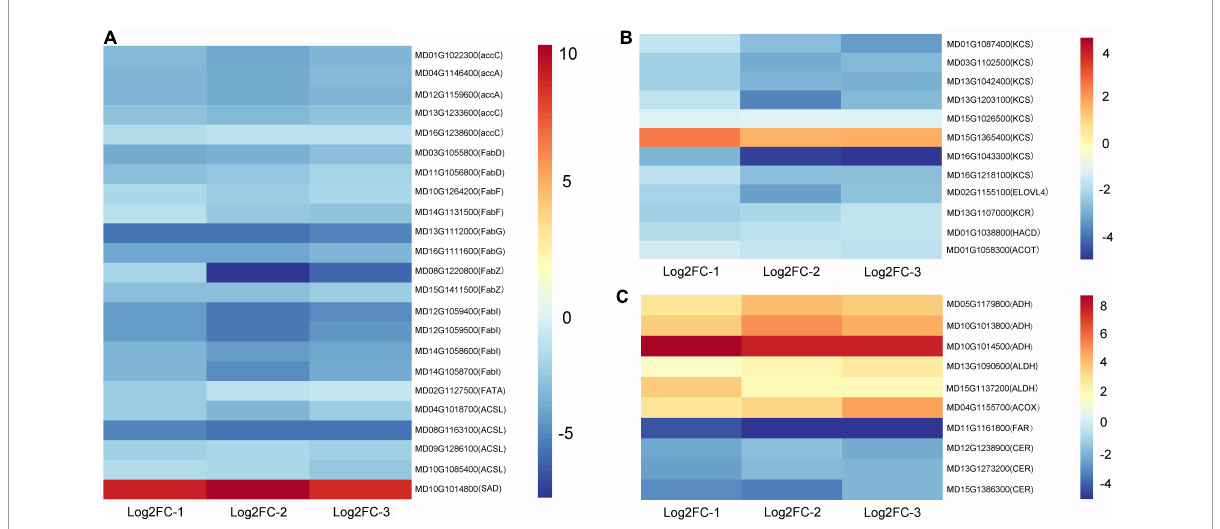
FIGURE4 Heat maps of fatty acid and wax-related DEGs after waxing treatment in apple fruit. Selected DEGs related to fatty acid biosynthesis (A) , fatty acid elongation (B) , fatty acid degradation and wax biosynthesis (C) from RNA-Seq date. Log2FC-1, Log2 (Fold Change) value of Waxed-1 and Control-1 in apple fruit RNA-Seq; Log2FC-2, Log2 (Fold Change) value of Waxed-2 and Control-2 in apple fruit RNA-Seq; Log2FC-3, Log2 (Fold Change) value of Waxed-3 and Control-3 in apple fruit RNA-Seq. The scale bar indicates upregulated (red) and downregulated (blue)